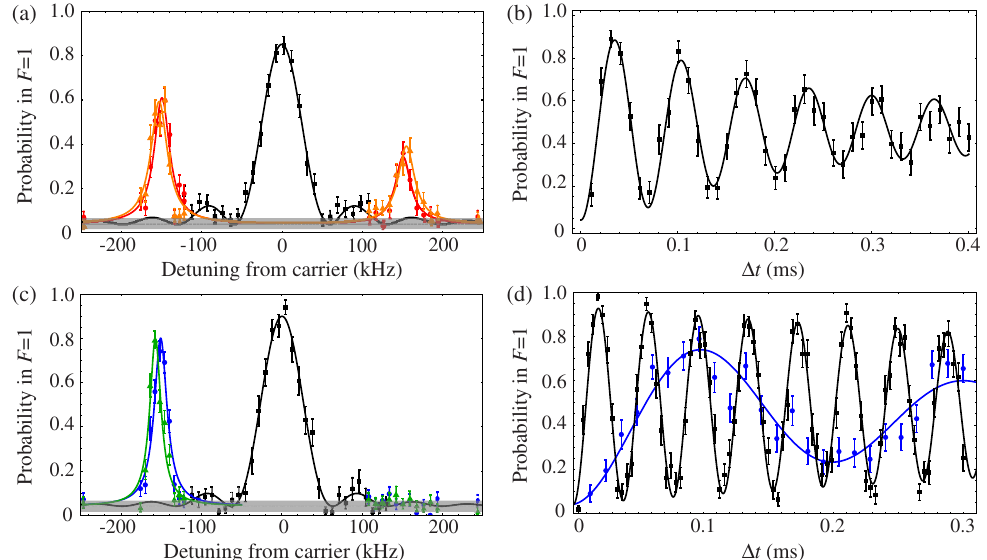
FIG. 2. Single-atom sideband spectra and Rabi oscillations in the radial dimensions before (a),(b) and after (c),(d) ground-state cooling. (a) The black squares are a carrier peak in the y 0 direction using a (cid:2) t ¼ 15 - (cid:4) s (near- (cid:2) ) pulse. The red circles (orange triangles) are sidebands along the y 0 ( x 0 ) axis for a 75 - (cid:4) s (near- (cid:2) ) pulse, demonstrating an initial thermal population of vibrational states. The solid lines are fits to a Rabi sinc function (defined in Supplemental Material, Ref. [35]) for the carrier and Lorentzians (an approximation) for the sidebands; each fit contains an offset at our measured background (gray shaded region centered at 0.04). (b) Carrier Rabi oscillations for the y 0 direction showing dephasing of a thermal state. Here, the carrier Rabi frequency is set to 15 kHz, instead of the usual 26 kHz. The solid line is a fit to the data using a thermal distribution of Rabi frequencies. (c) Raman-cooled radial sidebands; no Raman cooling is applied to the axial direction for these data. The black squares are a cooled carrier peak using a 15 - (cid:4) s pulse. The blue circles (green triangles) are spectra along the y 0 ( x 0 ) axis using a 75 - (cid:4) s pulse, displaying a significant asymmetry that is the hallmark of a large ground-state population. (d) Rabi oscillations for a radial ground-state cooled atom with a fit to a damped sine for the carrier (black squares) and the (cid:2) n ¼ þ 1 sideband (blue circles), which demonstrates coherent control of the spin-motional states; the carrier dephasing is suppressed due to the purity of the vibrational distribution. Each data point is an average of 150 experimental runs, and hence approximately 75